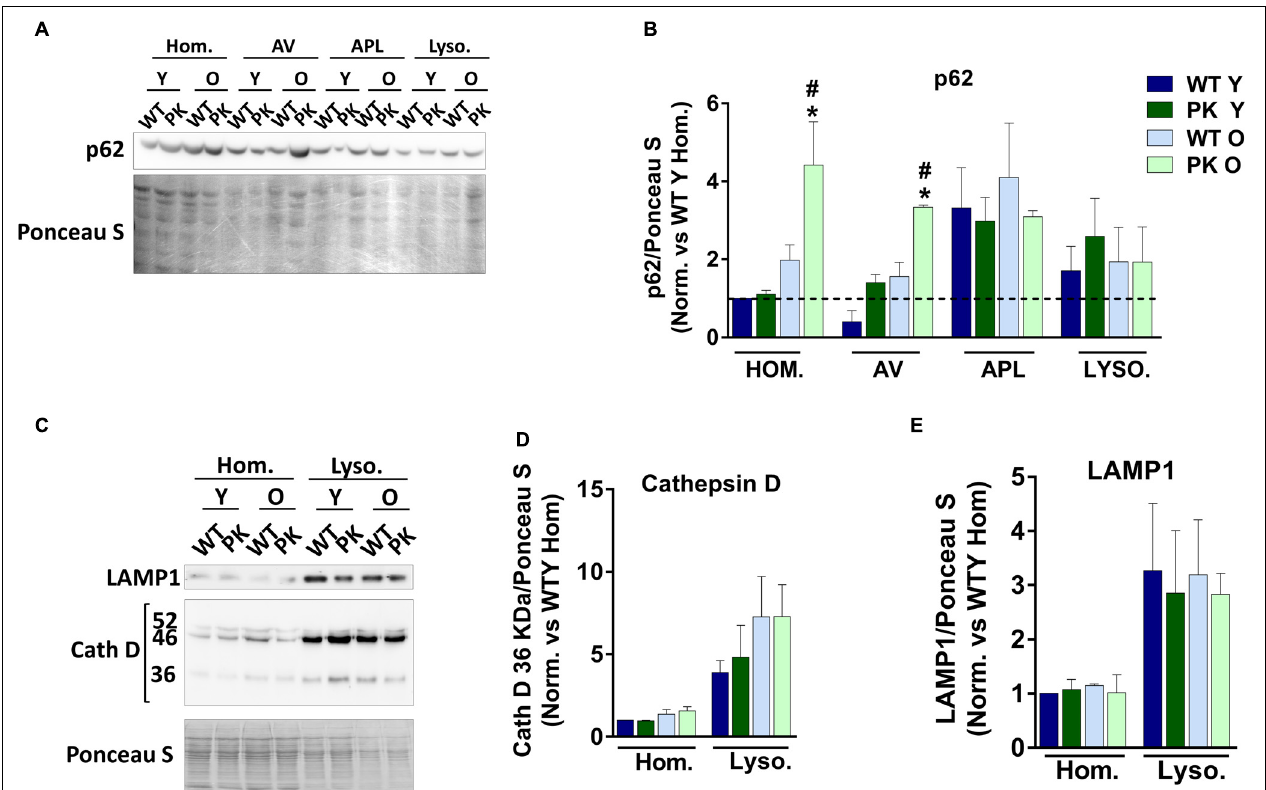
FIGURE 6 | Autophagy related markers in subcelluar fractions from brain and changes due to aging and parkin loss. p62 accumulates in PK-KO old mice autophagosomes but not in autophagolysosomes or lysosomes. (A) Representative image of a Western-Blot experiment showing p62 levels in the different subcellular fractions isolated. (B) Quantification of p62 intensity in brain’s subcellular fractions. (C) Western-Blot experiment showing LAMP1 and Cathepsin D levels in homogenates and lysosomes. (D) Quantification of Cath D 36 KDa in brain’s subcellular fractions. (E) Quantification of LAMP1 intensity in brain’s subcellular fractions. Graphs represent the mean ± SEM. Statistical analysis was performed by One Way ANOVA test. ∗ p < 0.05 due to aging. # p < 0.05 due to Parkin loss. n = 3–5 preparations of three mice